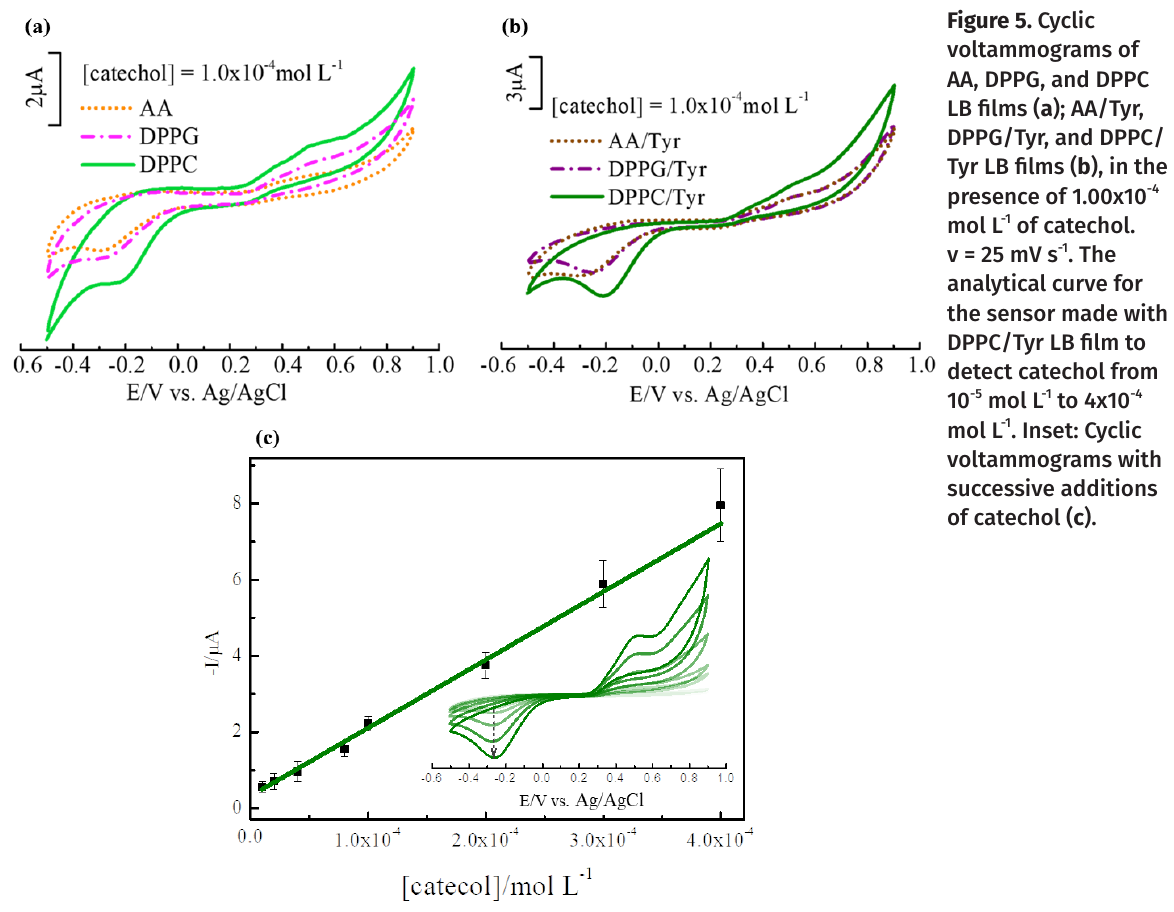
Figure 5. Cyclic voltammograms of AA, DPPG, and DPPC LB films ( a ); AA/Tyr, DPPG/Tyr, and DPPC/ Tyr LB films ( b ), in the presence of 1.00x10 -4 mol L -1 of catechol. v = 25 mV s -1 . The analytical curve for the sensor made with DPPC/Tyr LB film to detect catechol from 10 -5 mol L -1 to 4x10 -4 mol L -1 . Inset: Cyclic voltammograms with successive additions of catechol ( c